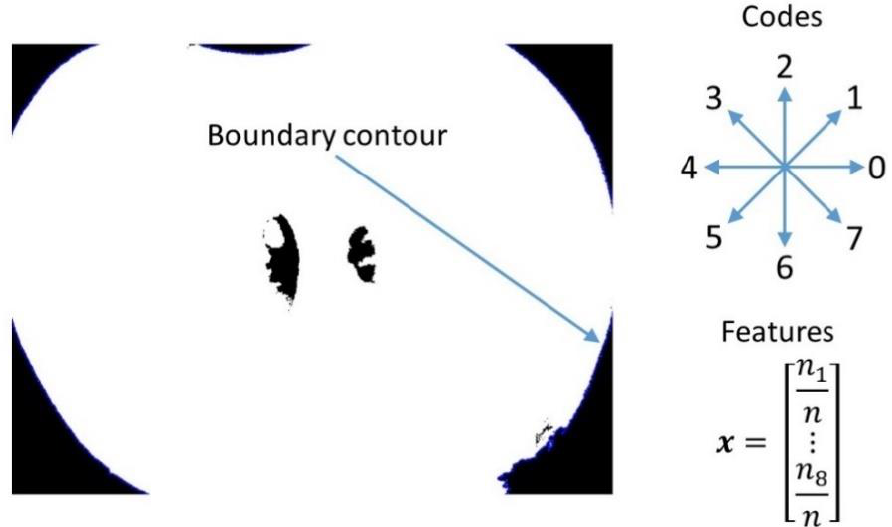
Figure 4. Example of the boundary contour of an apple slice, codes and directions of eight straight line segments (codes), shape feature vector.